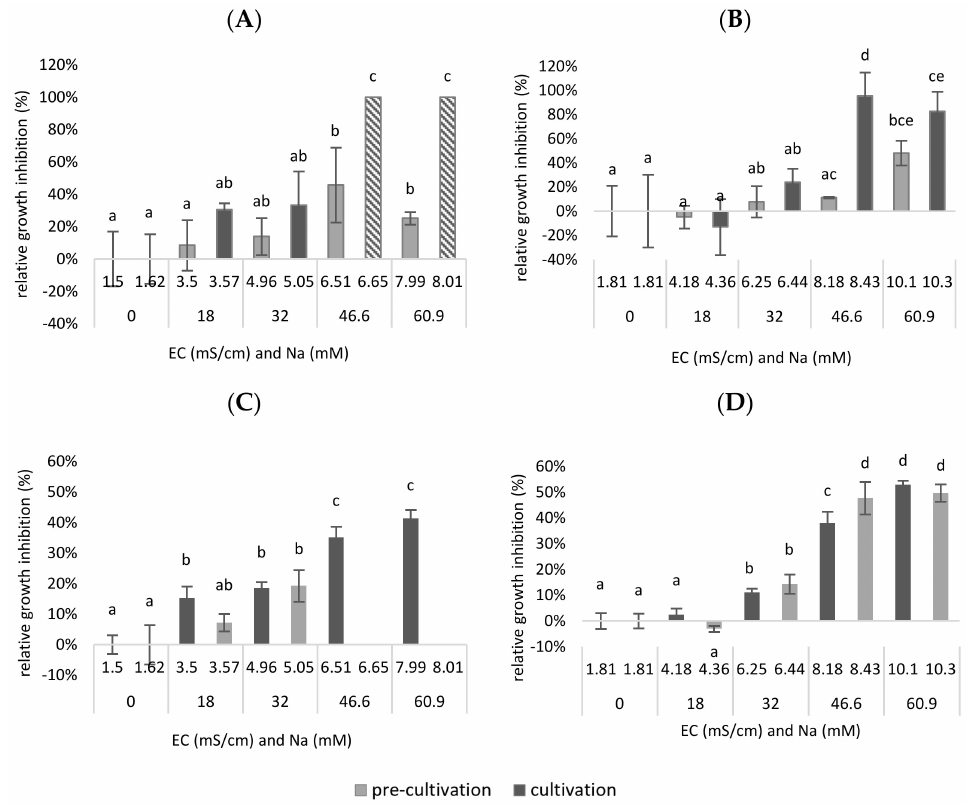
Figure 5. The relative growth rate inhibition of duckweed cultivated on a synthetic medium after NaCl addition ( A ) or NaCl, Na 2 SO 4 and K 2 SO 4 addition ( B ); the chlorophyll inhibition of duckweed cultivated on a synthetic medium after NaCl addition ( C ); or NaCl, Na 2 SO 4 and K 2 SO 4 addition ( D ). On the x-axis both the EC and the concentration of sodium in the medium is shown. A distinction is made between pre-cultivation and cultivation. For the inhibitions of the first experiment ( A , C ) there was no data obtained for the duckweed during cultivation grown on a medium with 46.6 and 60.9 mM Na due to die-off; therefore, in the RGRinh graph, a default value of 100% inhibition was taken (= no growth). Significant differences (n = 4 and p < 0.05) per graph are indicated by different letters. Error bars indicate standard